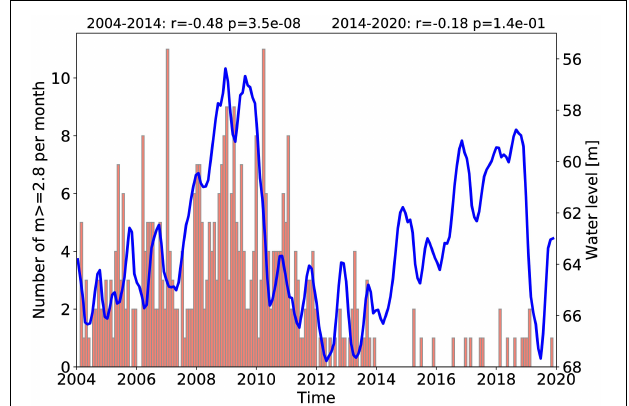
FIGURE 4 | Time evolution of the water level and the earthquake activity (declustered, M ≥ 2.8). Here the y-scale is reversed with values referring to the changes relative to the start of the impoundment. A similar plot with a normal y-scale is provided in Supplementary Figure 2 . The corresponding correlation coefficients (r) for the periods 2004–2014 and 2014–2020 are provided in the title line together with the corresponding p -value (significance for p <